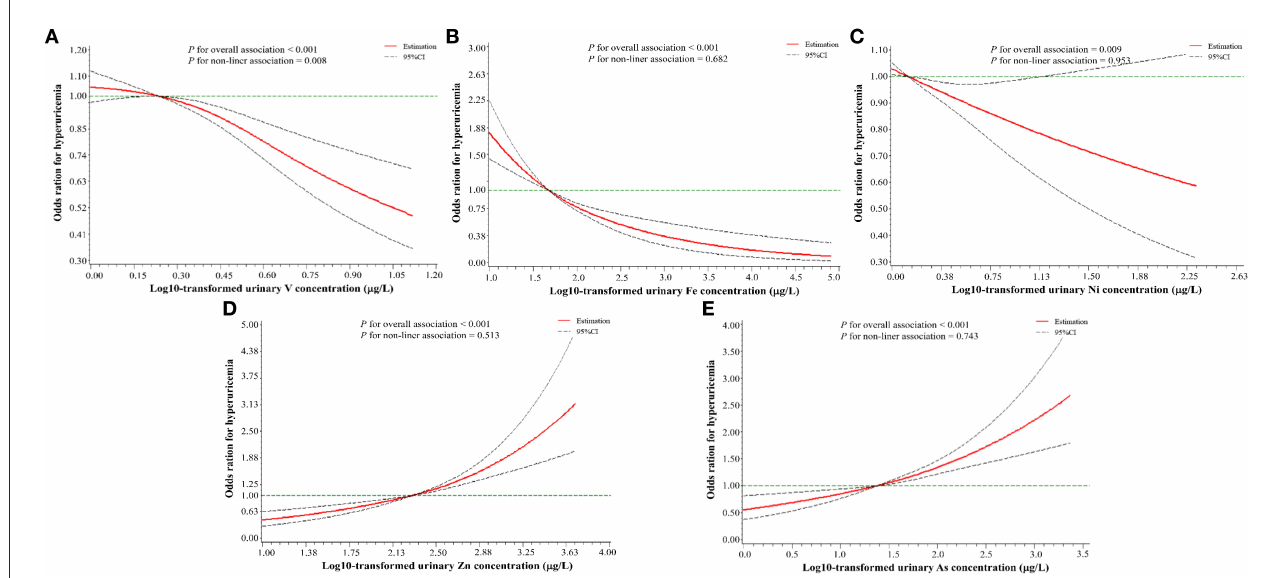
FIGURE3 A restricted cubic spline regression model with three knots (the 10th, 50th, and 90th percentile) for urinary metals levels and hyperuricemia risk. (A) V (vanadium); (B) Fe (iron); (C) Ni (nickel); (D) Zn (zinc); (E) As (arsenic). The X-axis indicates the log10-transformed urinary metal concentrations. Odds ratios (OR) and 95% confidence intervals were estimated, and metal concentrations (log10-transformed) at the 25th percentile were used as the reference value. All of the restricted cubic spline regression models were constructed after adjusting for age, gender, education level, marital status, active smoking status, passive smoking status, drinking status, hypertension, diabetes, hyperlipidemia, BMI, eGFR, and urine